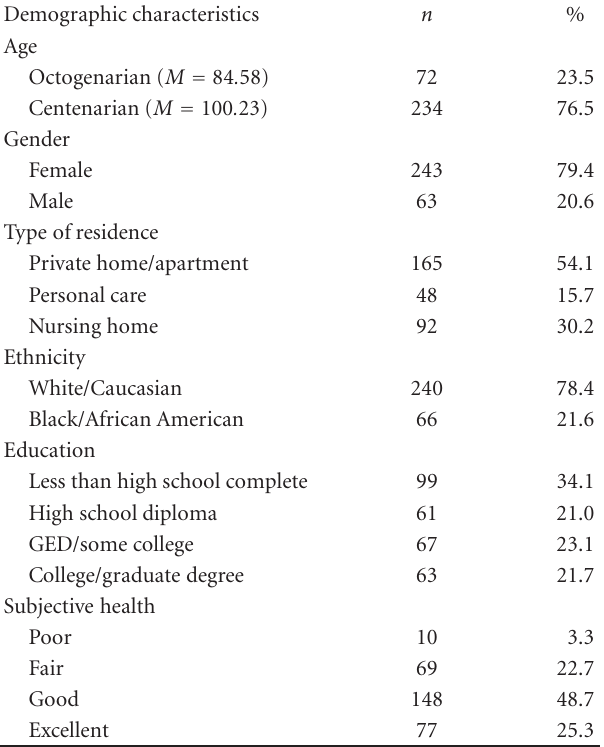
Table 1: Summary of demographic